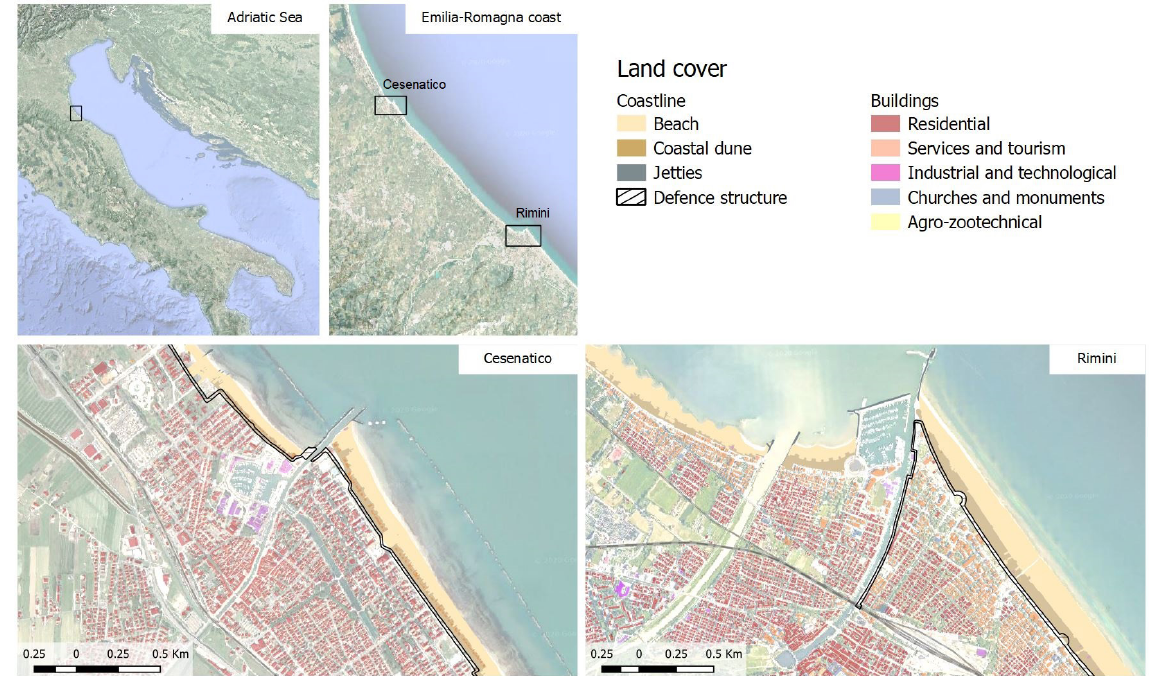
Figure 1. Case study locations along the Emilia-Romagna coast: Cesenatico and Rimini. The coastal defence structure assessed in this study are shown in black. Buildings’ footprint data are from the Regional Environmental Protection Agency (ARPA) 2020. Basemap © Google Maps